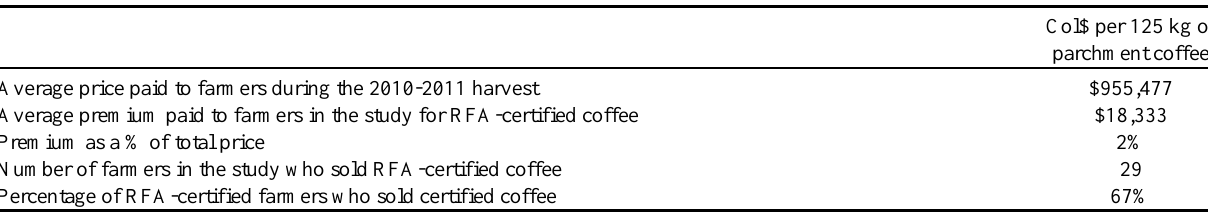
Table 3 . Price of Rainforest Alliance (RFA) certified coffee for the 2010-2011 harvest season, Santander, Colombia.